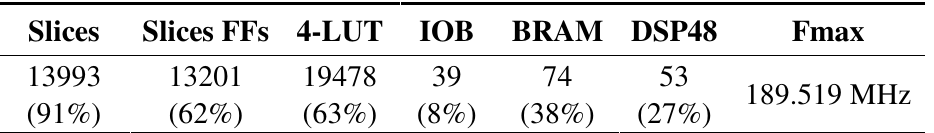
Table 3. Virtex-4